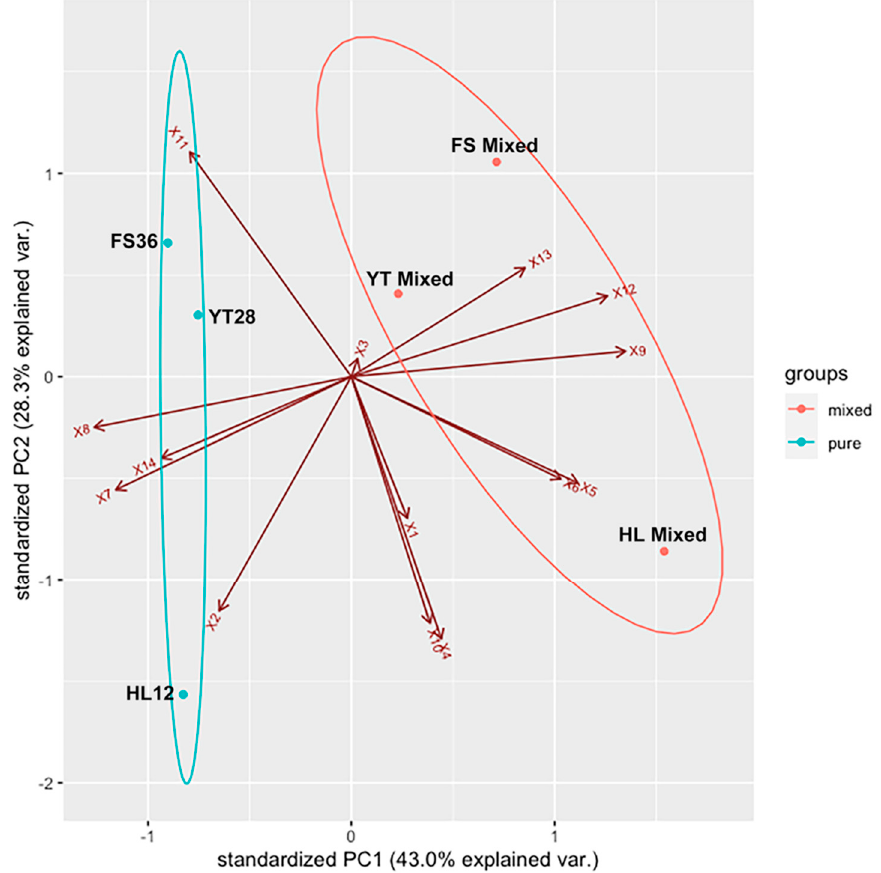
Figure 3. Principal Component Analysis (PCA) biplots of selected volatiles in six Marselan wines.